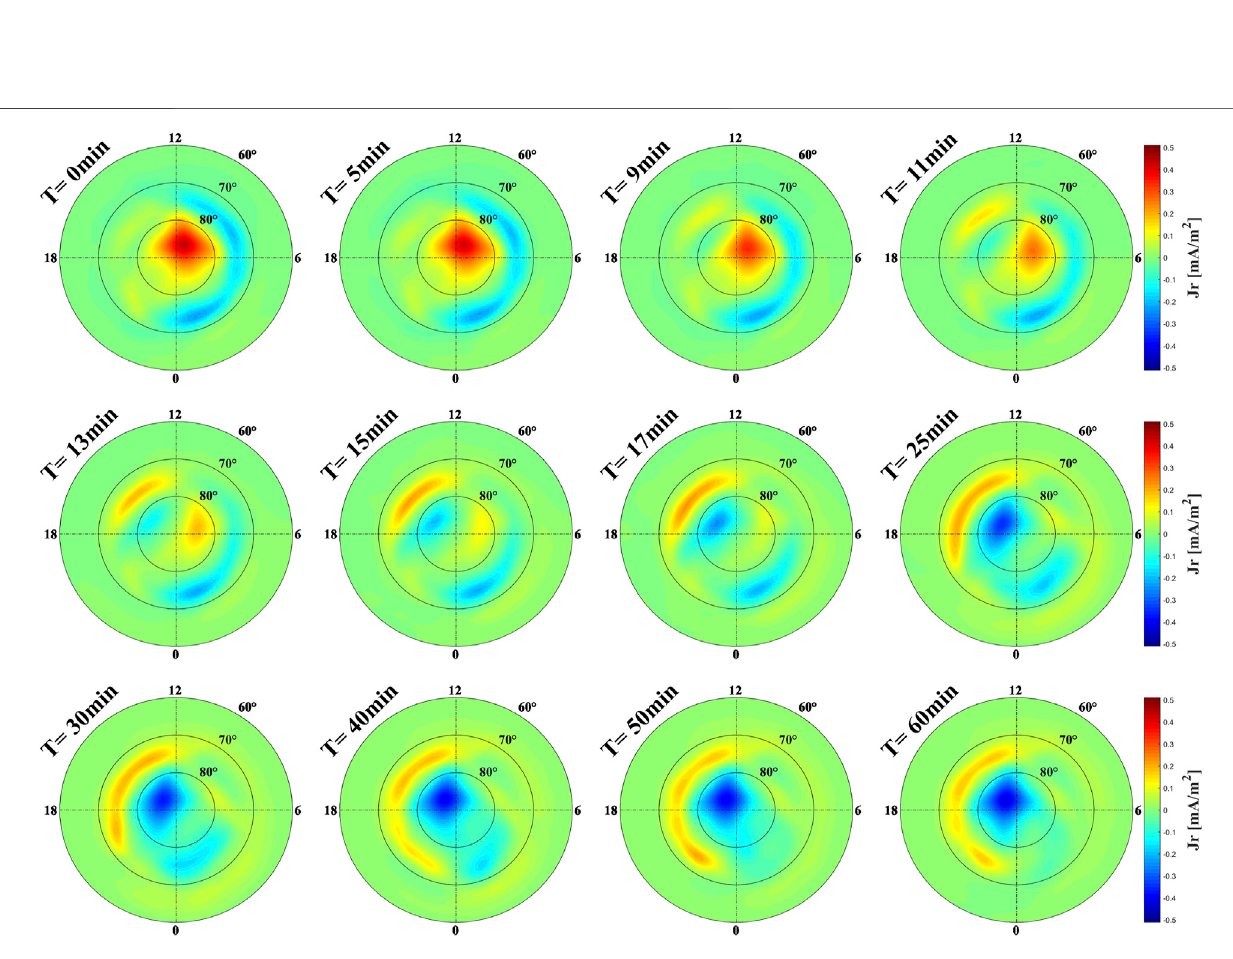
Frontiers in Physics |